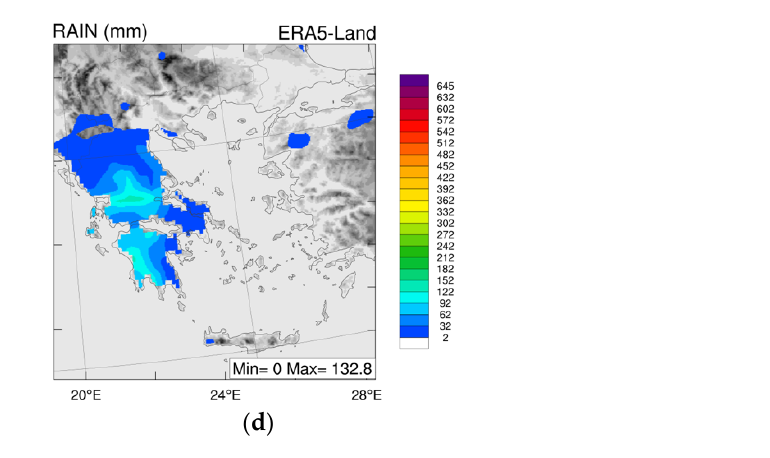
Figure 18. Bar chart depicting the average spatial values of the accumulated precipitation in mm from 12 to 18 UTC on 18 September 2020 for the high-resolution domain. Green corresponds to the FULL experiment forecasts, yellow to the GTS experiment, red to the NO experiment, and blue to the IMERG precipitation product.